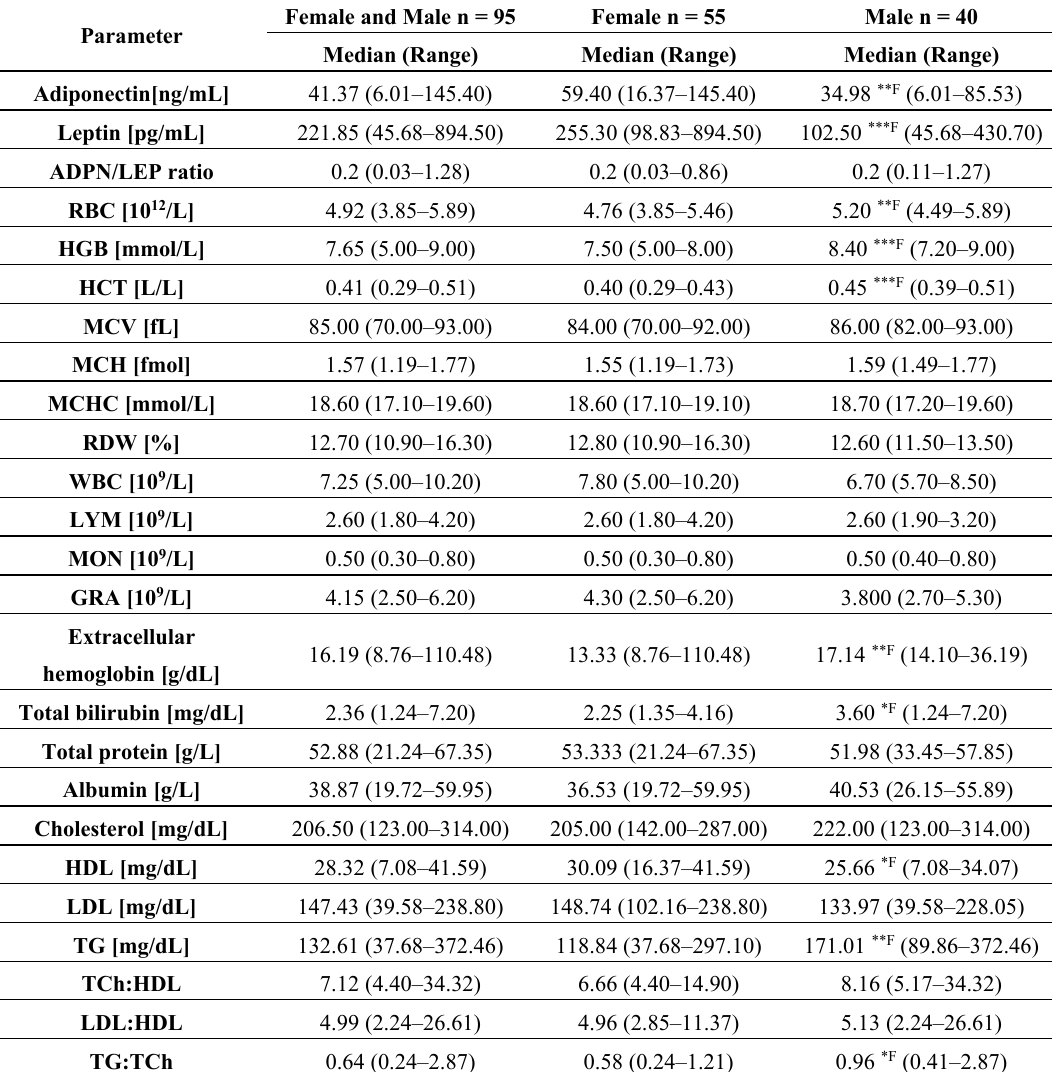
Table 2. Clinical and biochemical characteristics of the study